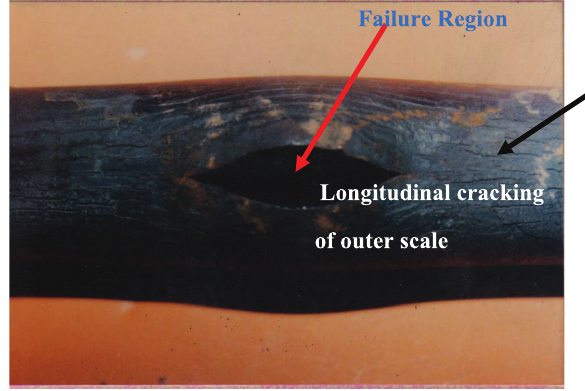
Fig. 2: As received failed tube showing failure region and longitudinal scale cracking